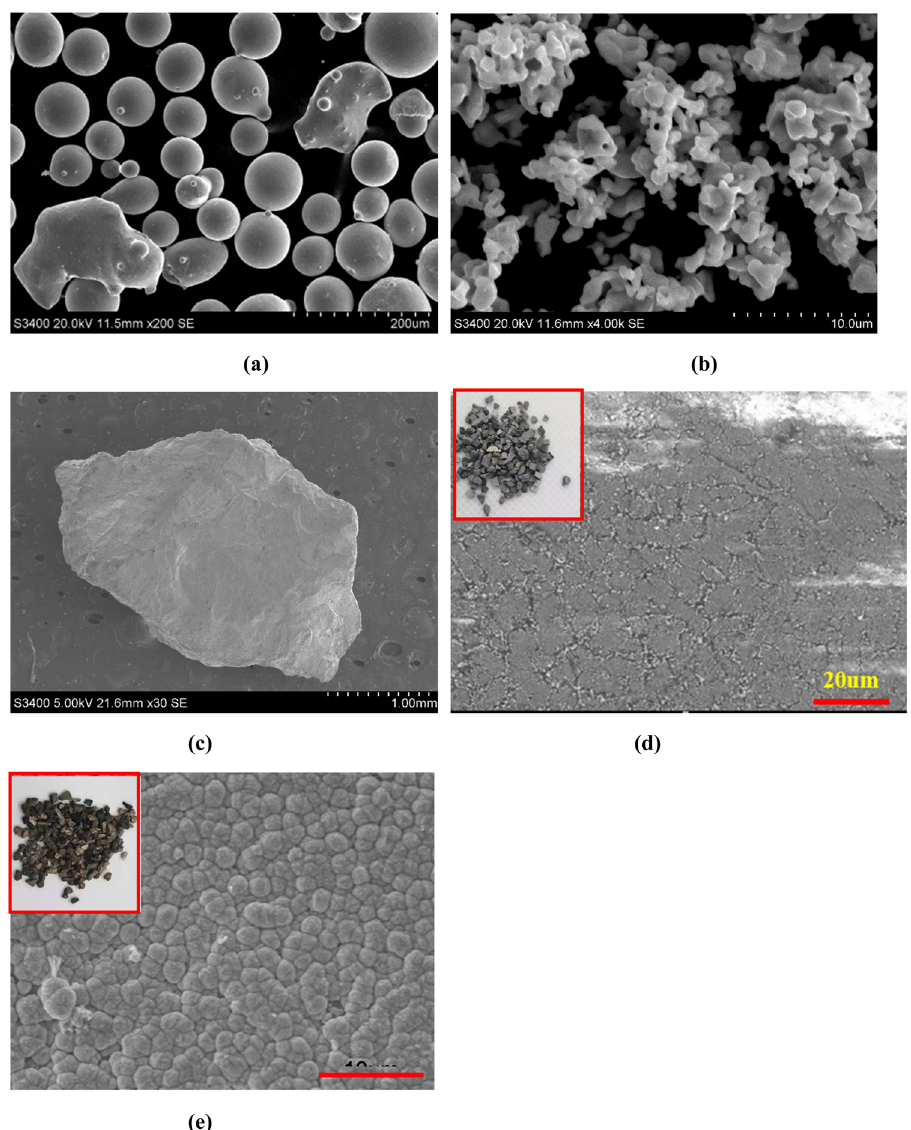
Figure 1: Morphology of Fe60, NbCp, and ZTAp: ( a ) Fe60, ( b ) NbCp, ( c ) ZTAp, ( d ) surface morphology of unmodi fi ed ZTAp, and ( e ) surface morphology of modi fi ed